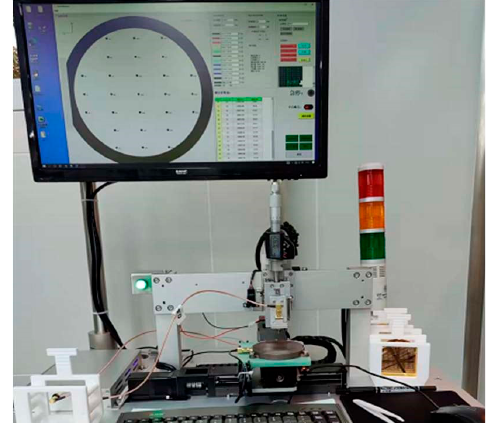
Figure 2. MT200 frequency tester.